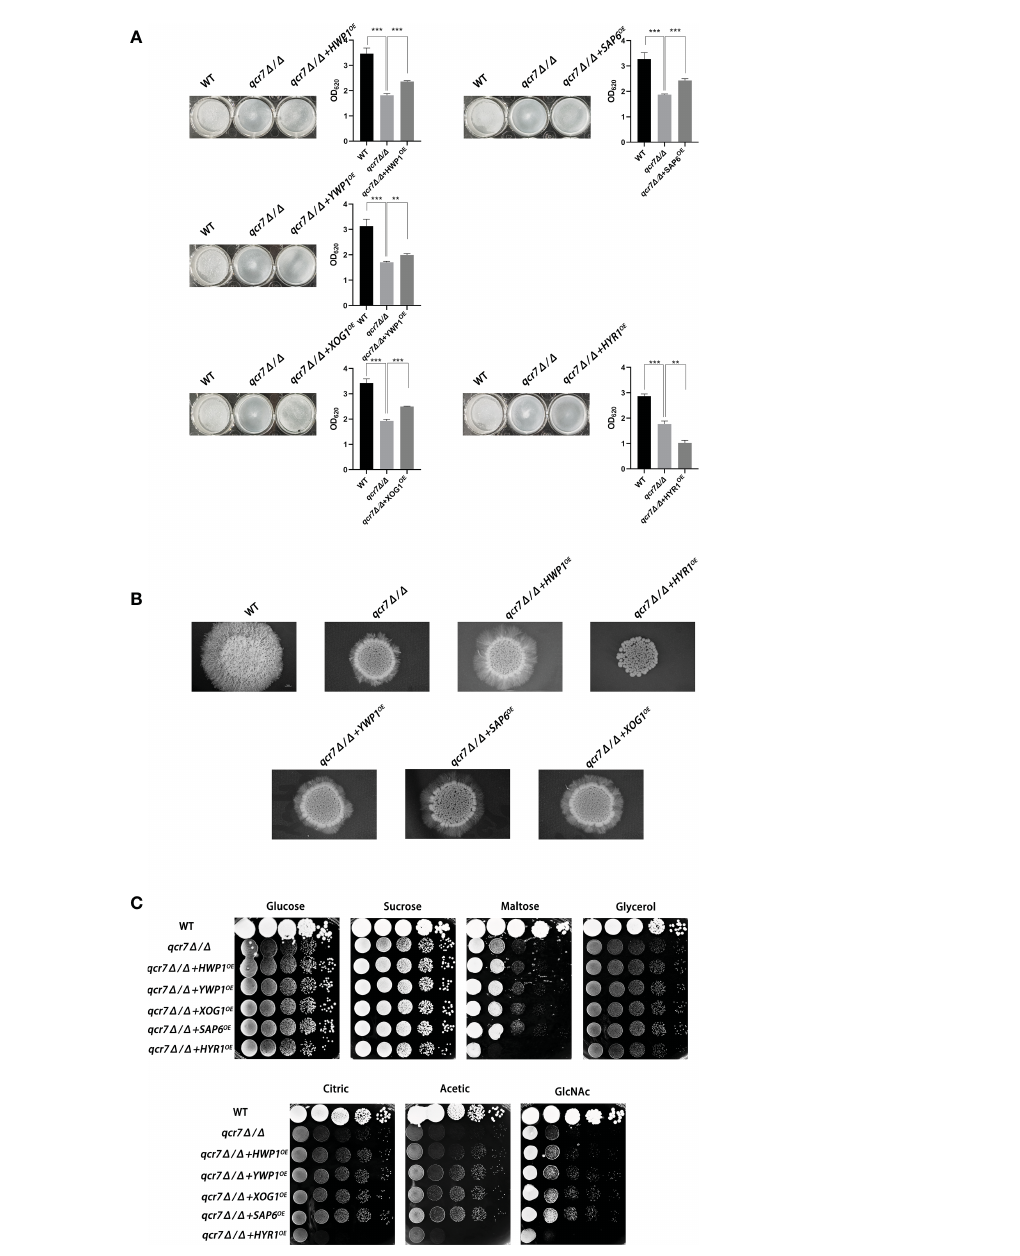
FIGURE 6 Bio fi lm formation, hyphal growth on solid, and spot assay on cell-wall stressors or multiple alternative carbon sources with WT, qcr7 D / D , HWP1 , YWP1 , XOG1 , SAP6 , and HYR1 overexpressing strains in the qcr7 D / D background. (A) Bio fi lm formation (48h, 37°C) of strains was pro fi led and statistically compared to reference strain C albicans SN250. (B) Each cell type (1 × 10 5 cells in 5 µl of PBS) was spotted on the Spider medium at 37° C. Photographs were then taken after 7 days of growth. (C) The sensitivities of wild-type strain, qcr7 D / D strain, and overexpression strain to different carbon-source conditions were observed by spot assay and incubation was conducted at 30°C for 2 days before photographs were taken. “ ** ” represents p < 0.01 and “ *** ” represents p < 0.001 for the WT or overexpressing strains vs. mutant